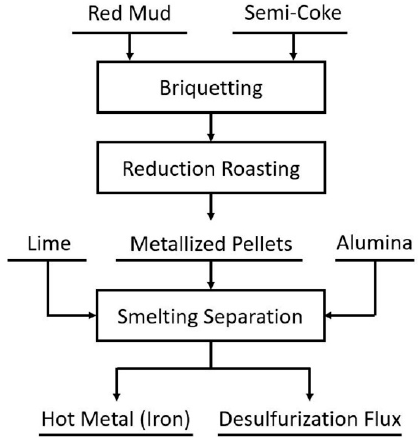
Figure 11. A new process for recycling of red mud.